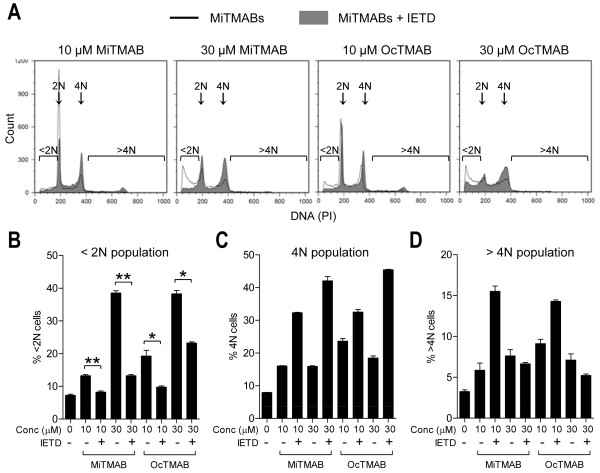
The caspase-8 inhibitor, IETD, only partially blocks cell death induced by MiTMABs. A-D, G2/M synchronized HeLa cells were treated with MiTMABs and controls as described in the legend to Figure 2, except that the caspase-8 inhibitor, IETD, was used instead of ZVAD. Representative flow cytometry histograms of HeLa cells treated with MiTMABs in the presence (filled histograms) and absence (empty histograms) of IETD are shown (A). Quantitation (mean ± S.D.) of cells containing <2N (B), 4N (C) and >4N (D) DNA contents were determined from two independent experiments. * p < 0.05, ** p < 0.01 (Student's t tests).